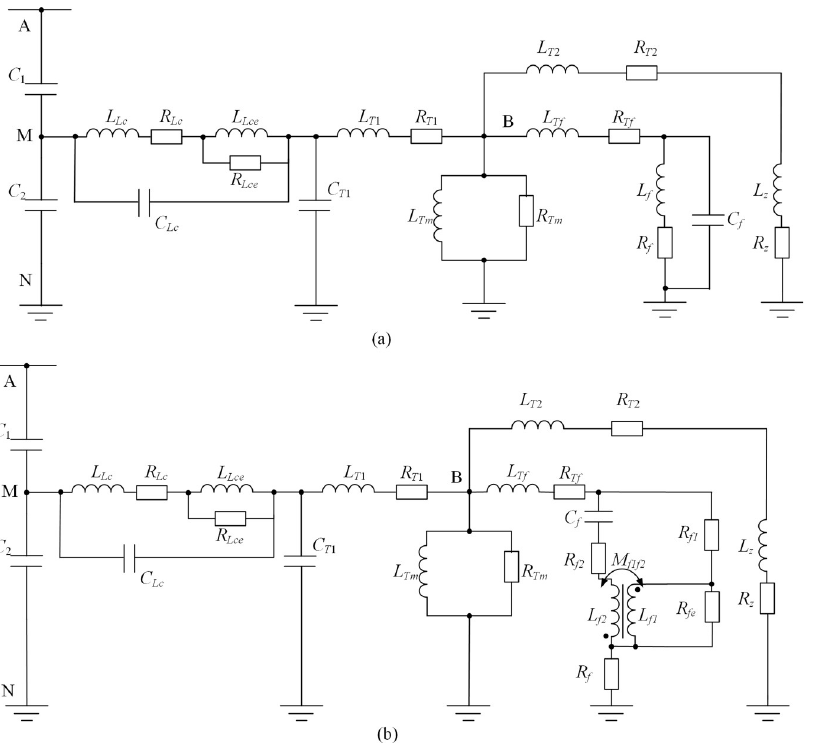
Fig 2. HECs of the CVTs. (a)With speedy saturation damper. (b) With resonance-type damper.